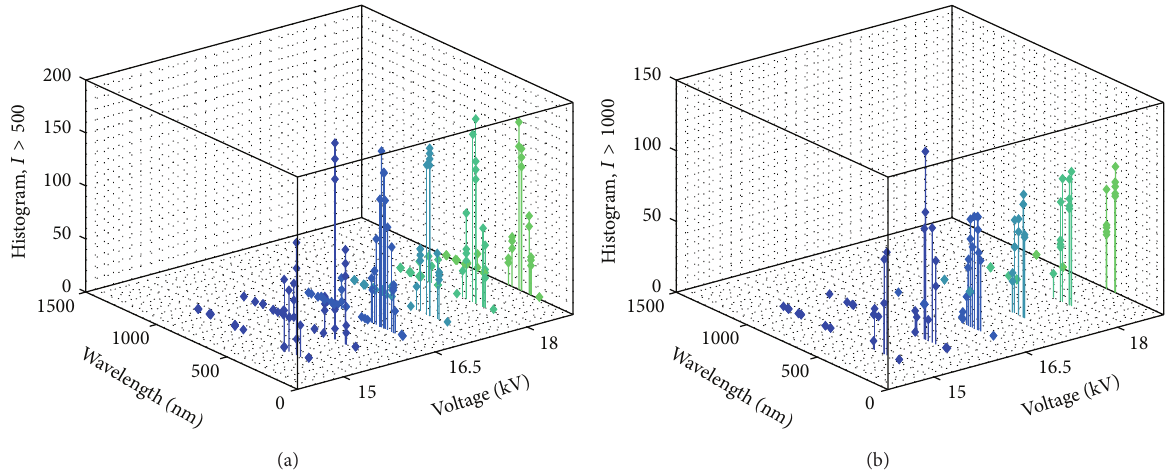
Figure 3: Summary of spectrum intensity histograms for different voltages: (a) 𝐼 > 500 and (b) 𝐼 > 1000 .